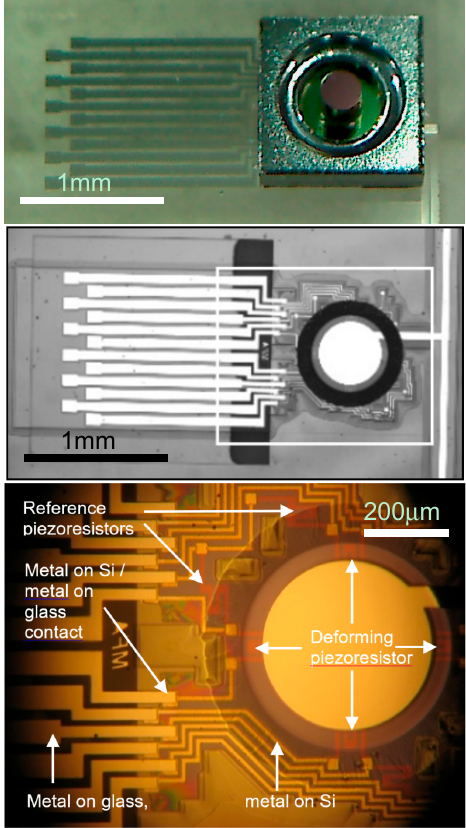
Figure 3. Vectorial piezoresistive force sensor ( top ). Optical views of wafer bonded chips as looking from the glass side ( middle and bottom ): overviews and magnified part of the active area. The auxiliary metal circles on the glass partially cover the Si membranes